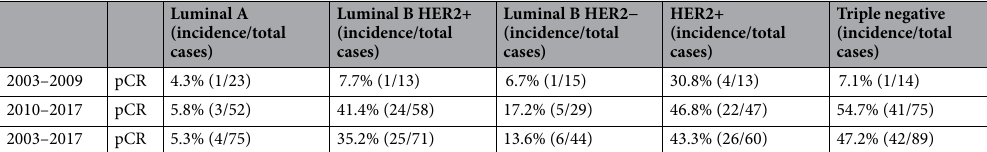
Table 5. Association between pathological complete response (pCR) and breast cancer intrinsic